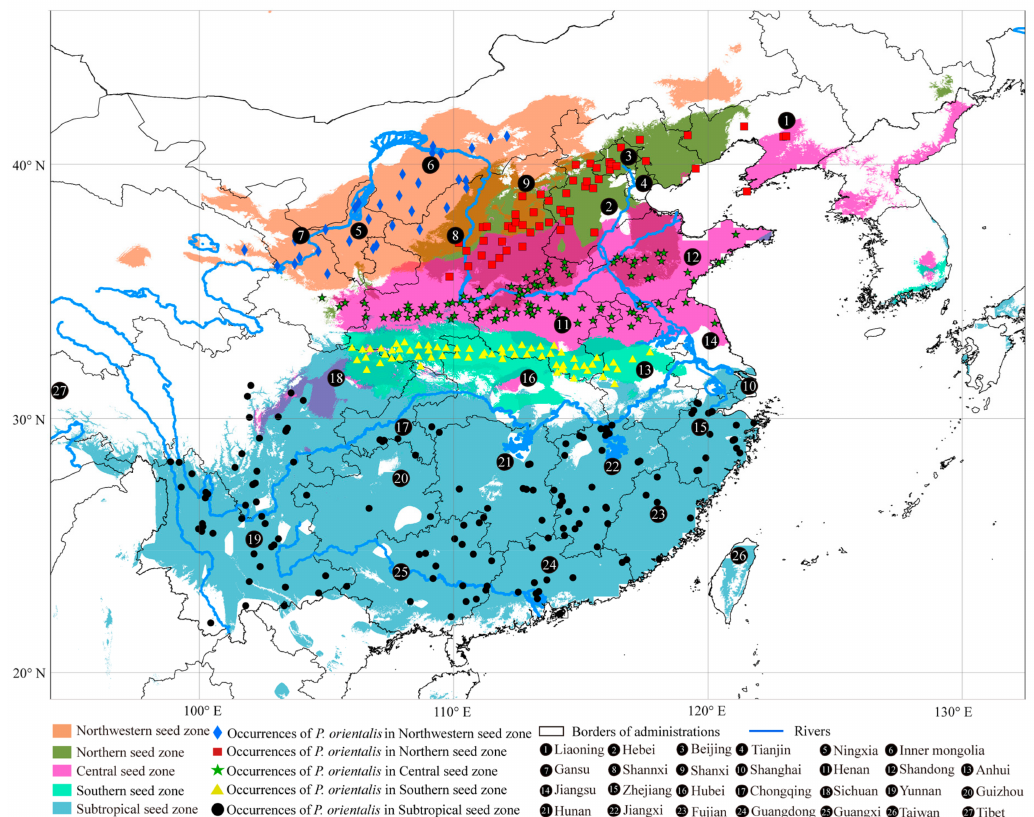
Figure 2. Suitablehabitatsforthefiveseedzonesof Platycladusorientalis